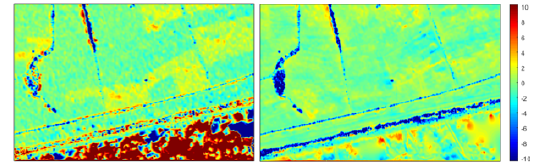
Figure 9. Height residual maps for agricultural and lake area: TanDEM-X DEM (Left) and Cartosat-1 DEM (Right)